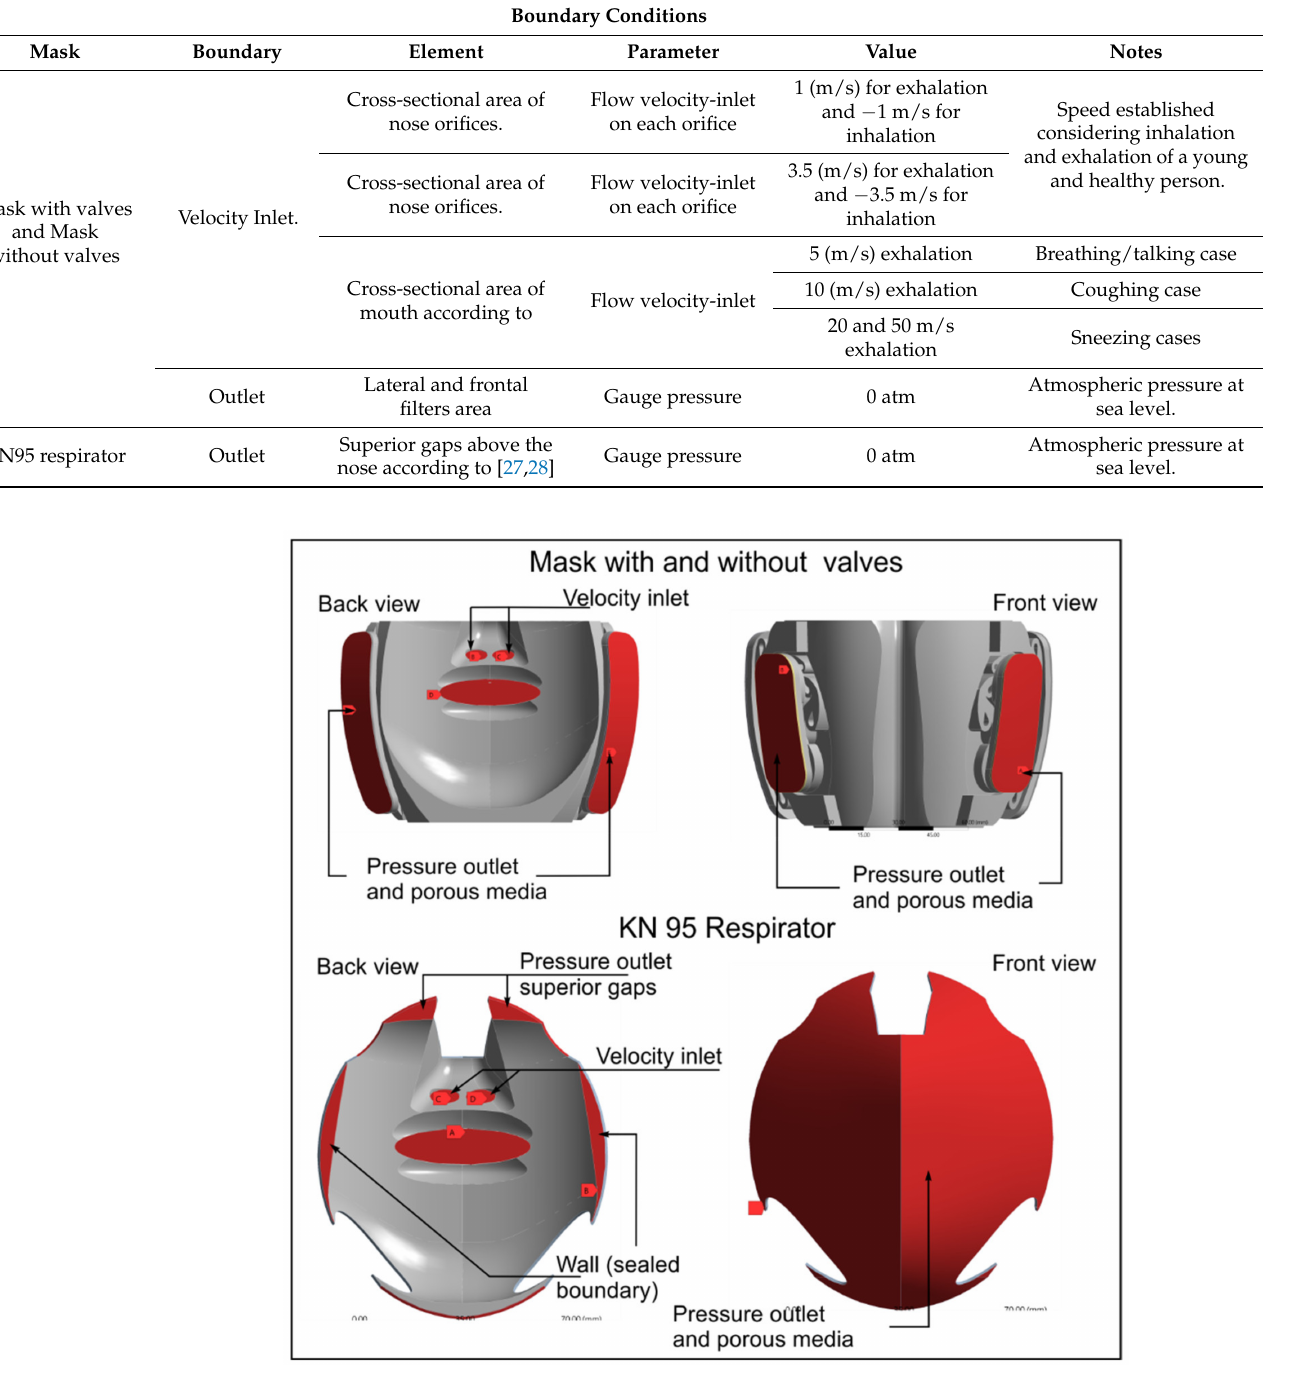
Figure 6. Boundary zones for each mask and respirator